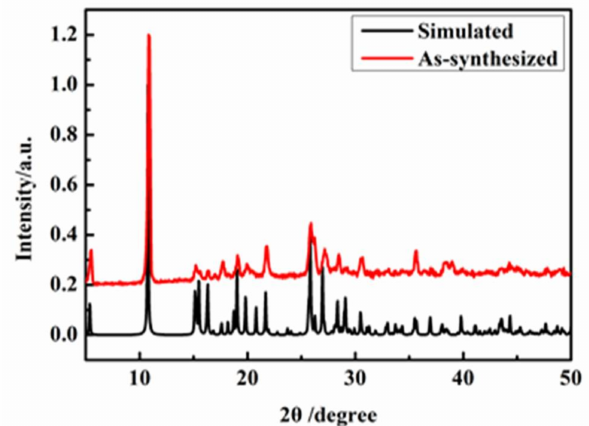
Figure 9. The PXRD spectrum of Complex 1 .